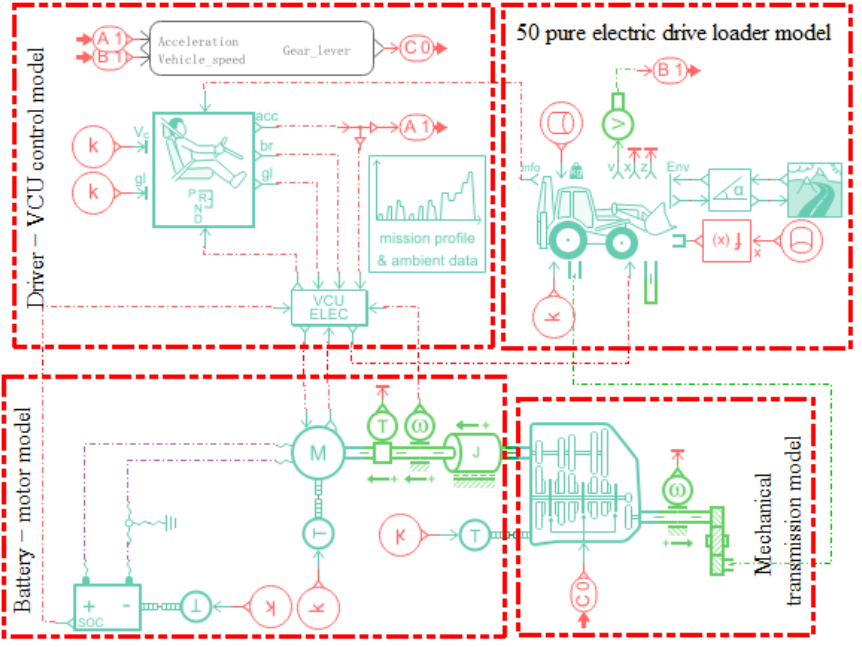
Figure 13. The automatic transmission shift rule based on the AMESim machine model.